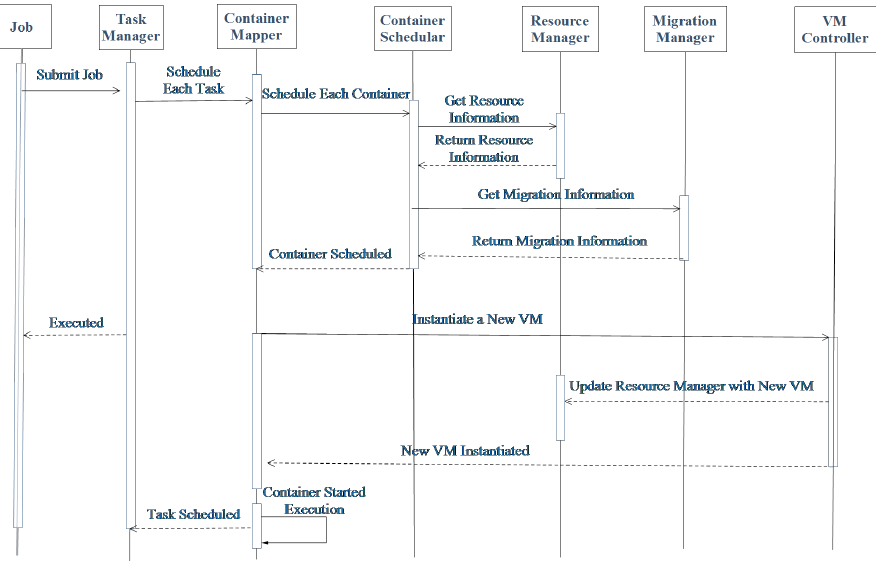
Figure 4. Sequence Diagram for Scheduling a Container in the CaaS